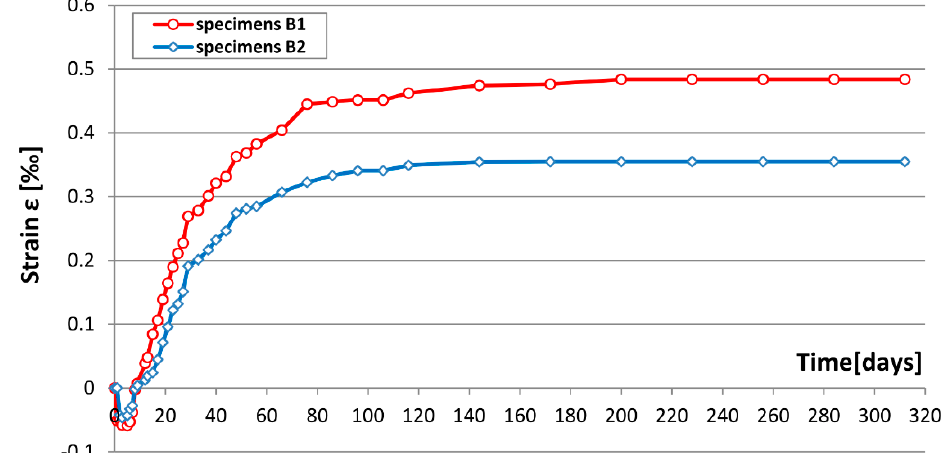
Figure 11. Changes of average shrinkage strain over time.